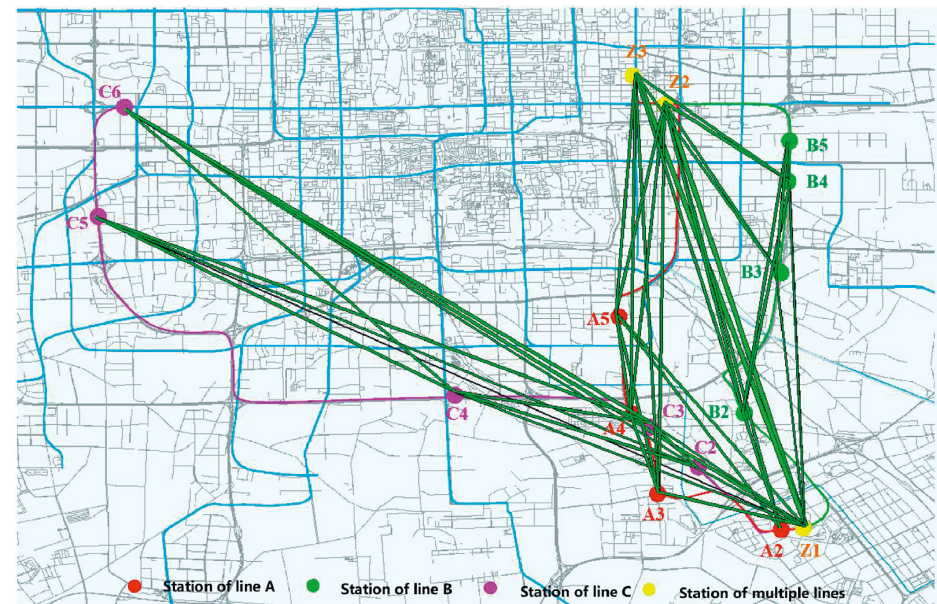
Figure 7: Spatial location distribution of OD Paris.